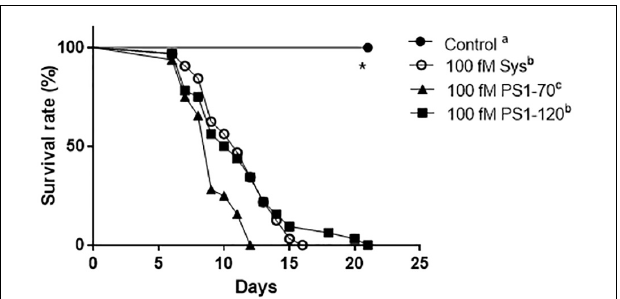
FIGURE 3 | Effect of 100 fM Sys, PS1-70 and PS1-120 on S. littoralis larvae. Survival rate of experimental S. littoralis larvae. Different letters denote significant differences in the survival curve (Log-Rank test, P < 0.0001).